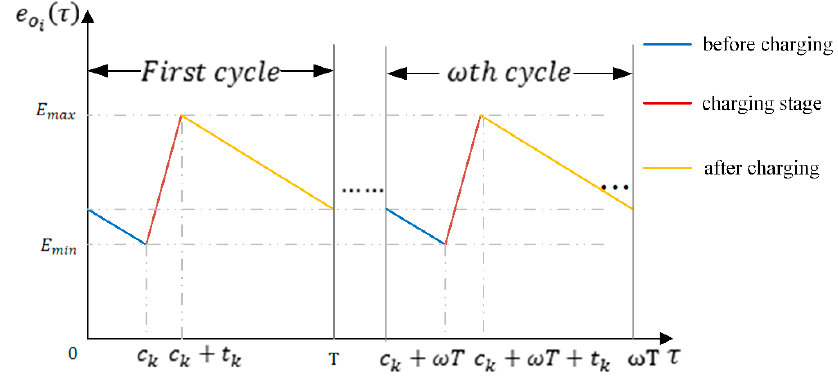
Figure 5. The variation of energy value function of node o i .